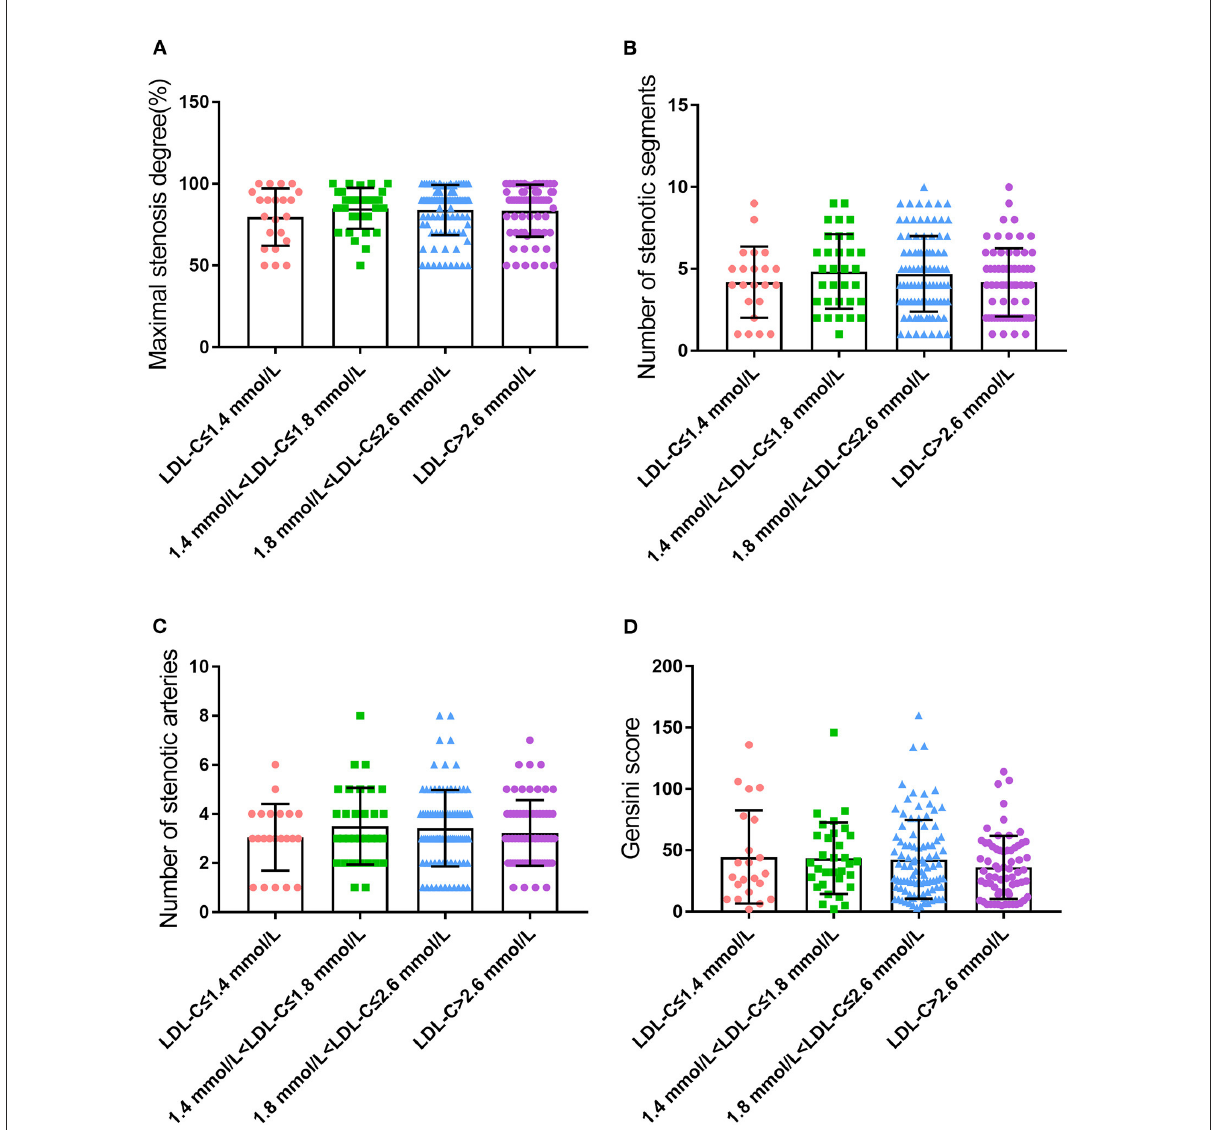
β -sheet content of serum protein